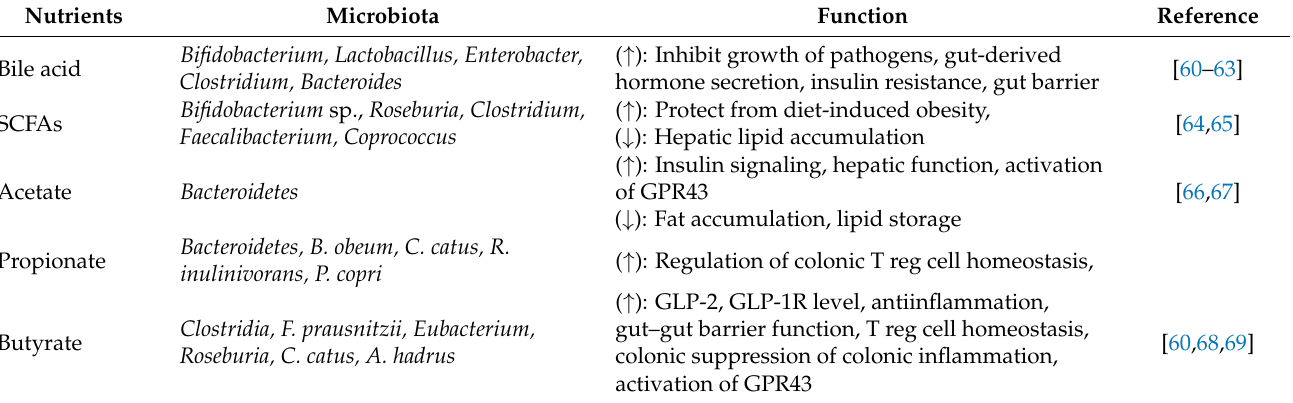
Table 3. Nutrients associated with microbiota in nonalcoholic fatty liver disease. Nutrients Microbiota Function